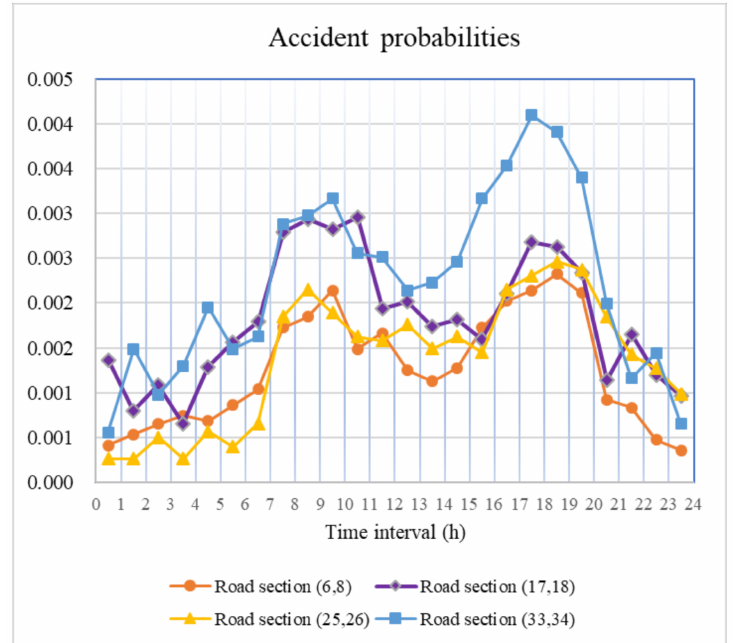
Figure 6. Accident